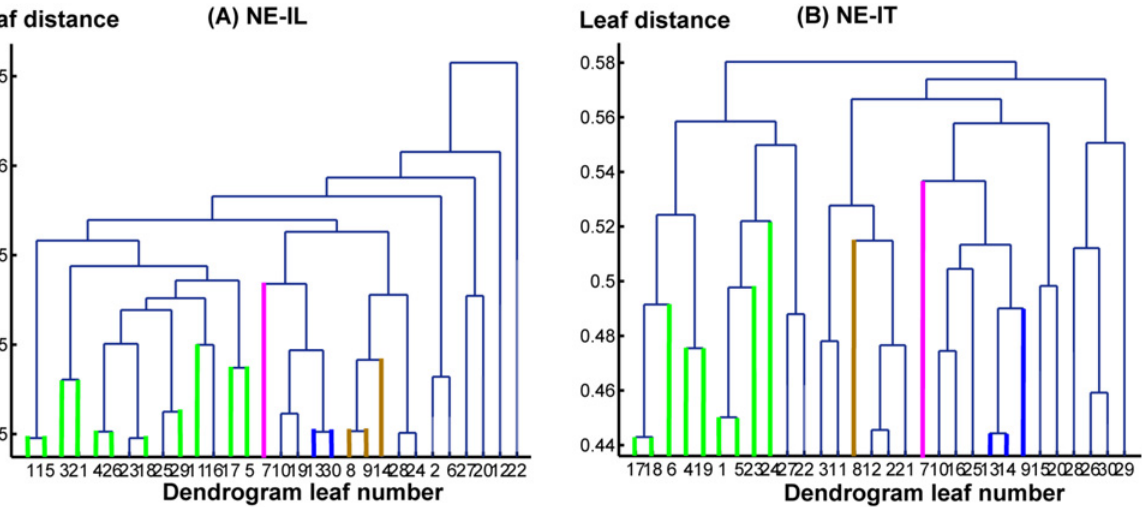
Figure 4. The hierarchy structures based on the dendrogram analysis for the NE-IL (A) and the NE-IT (B) conditions, respectively. The x-axis: leaf number, with each leaf representing a cluster of BAs. The y-axis represents leaf distance calculated using average linkage clustering based on correlation distance. The orange color indicates group A, the blue color indicates group B, the pink color indicates group C, and the green color indicates group D.